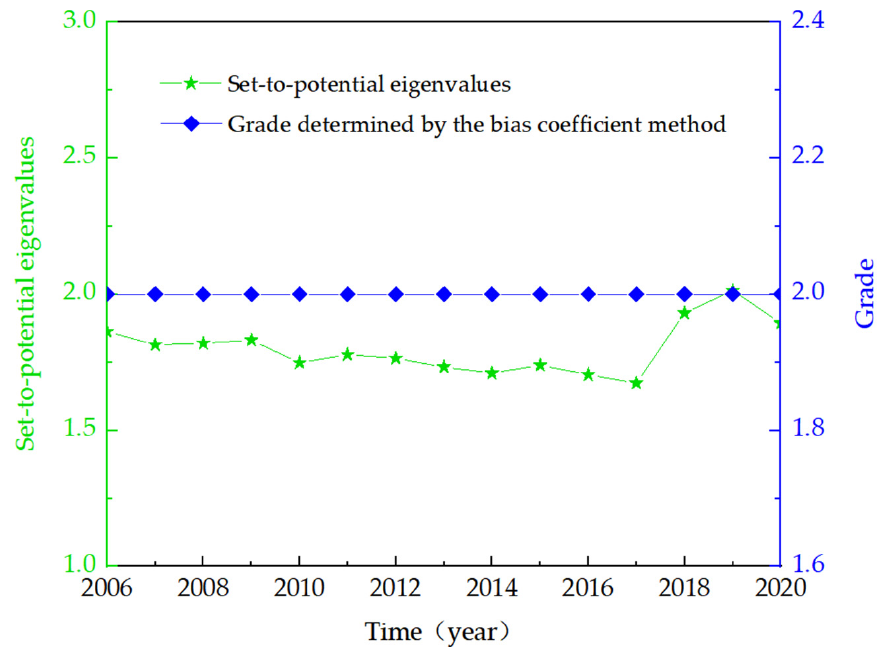
Figure 4. Set pair potential eigenvalues and grade determined by the partial coe ffi cient method.